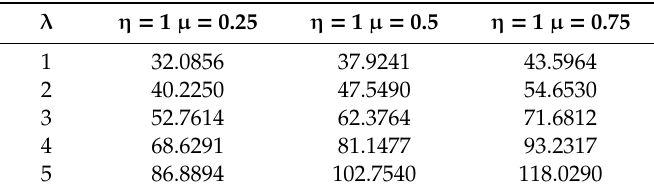
First five natural frequencies for the UD distribution for three di ff erent states of complete agglomeration.